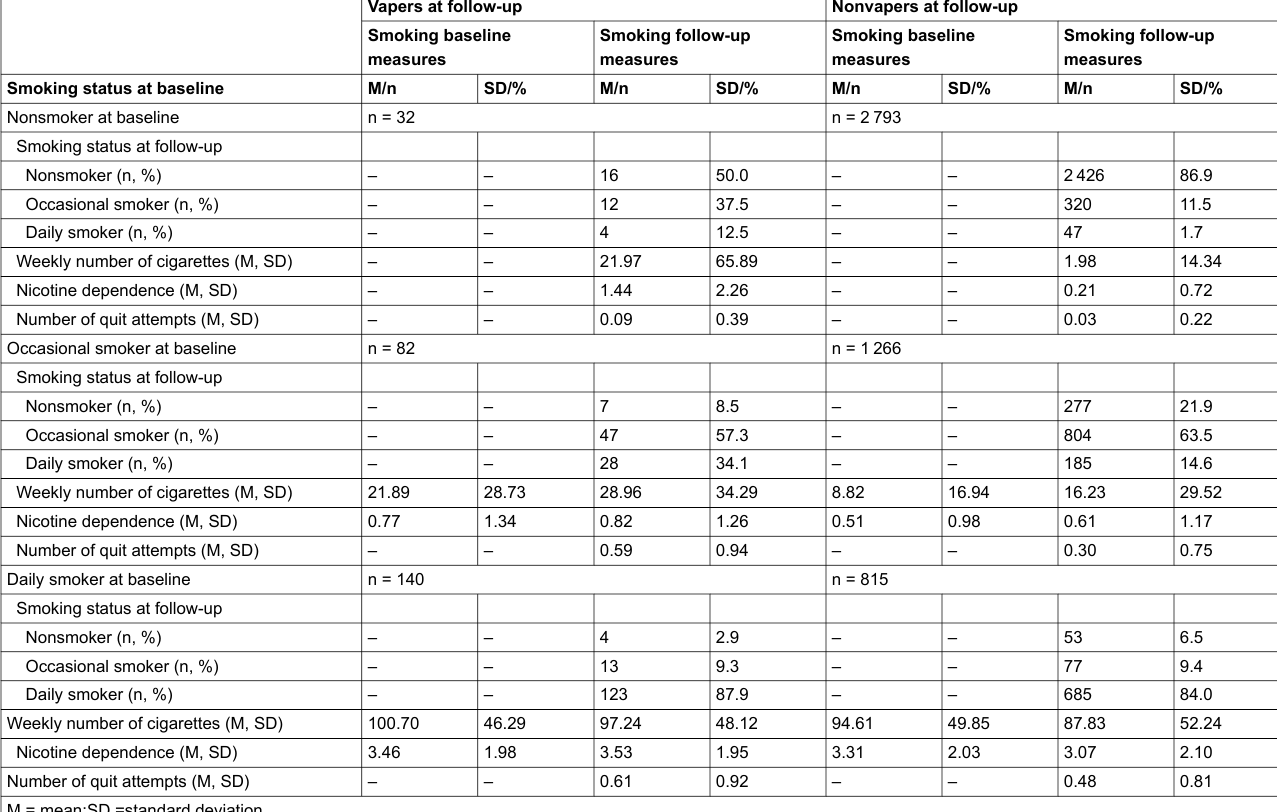
Table 2: Smoking characteristics at baseline and follow-up of vapers and nonvapers (measured at follow-up only) as a function of cigarette smoking status at baseline, Switzerland